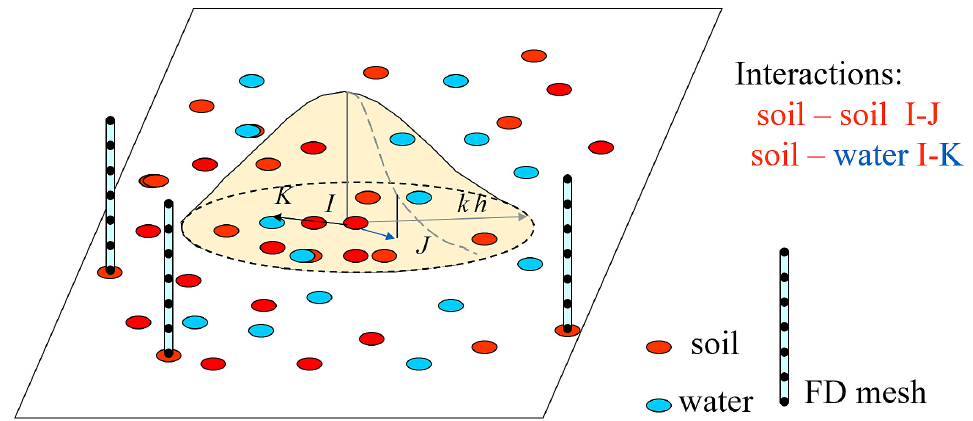
Figure 4. SPH integration in the particle support for two-phase: (1) soil–soil (I-J) and (2) soil–water (I-K) with a 1D finite-difference mesh at each SPH node that represents a solid